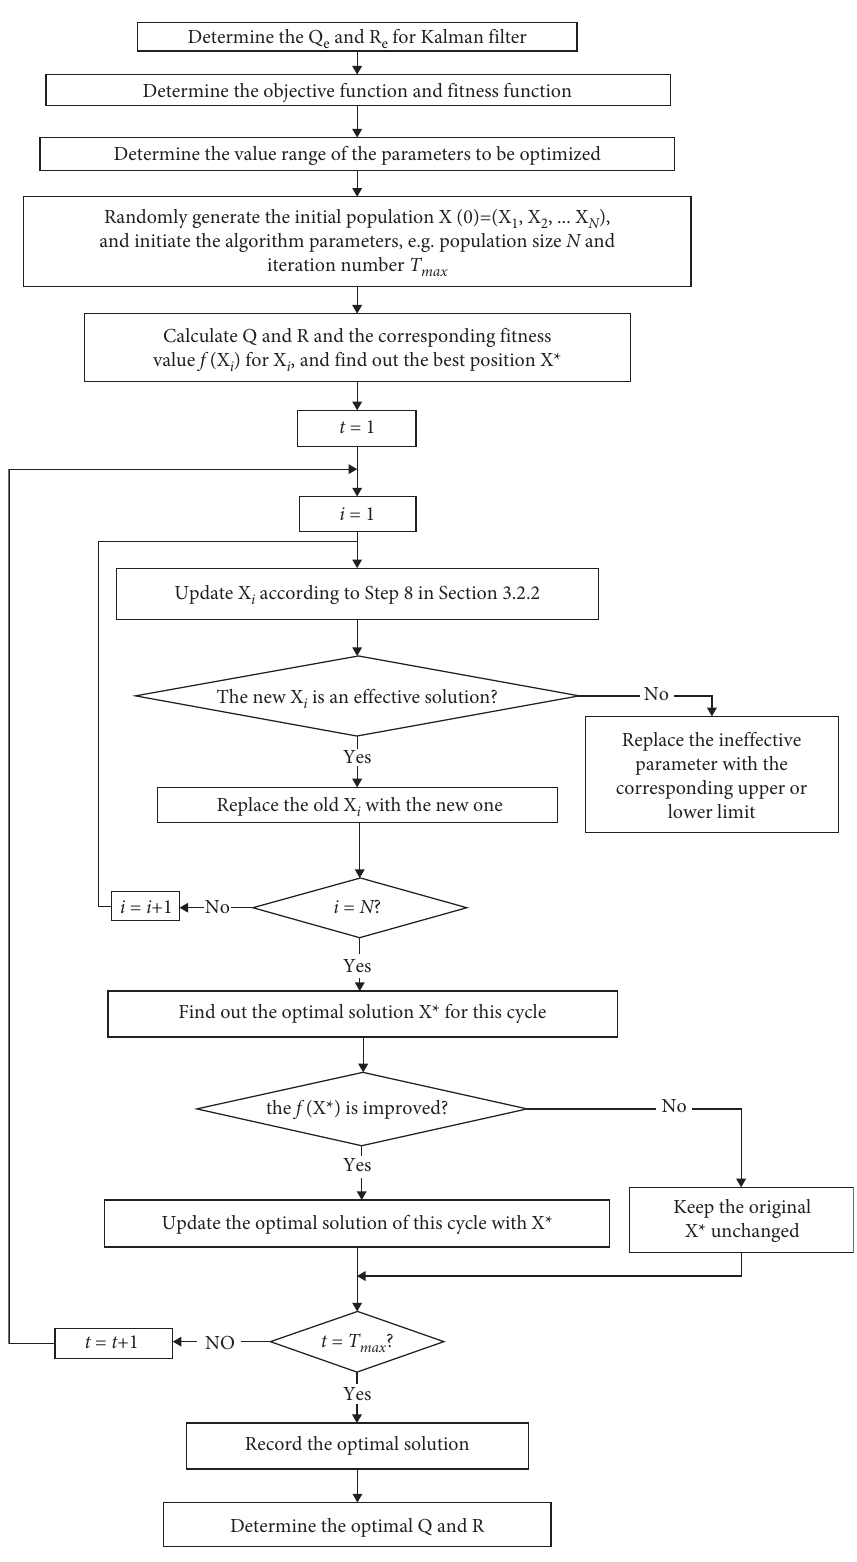
Figure 2: Optimization flowchart of the WLQG